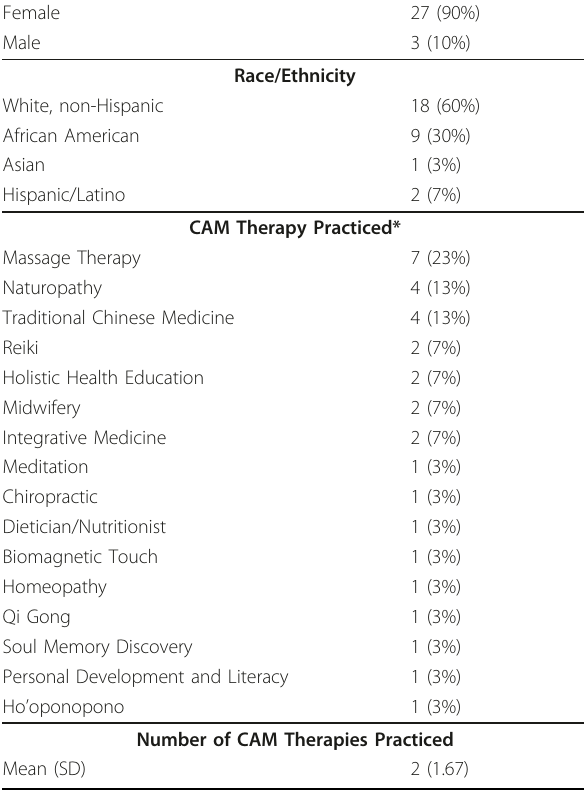
Table 3 Practitioner Characteristics for Item